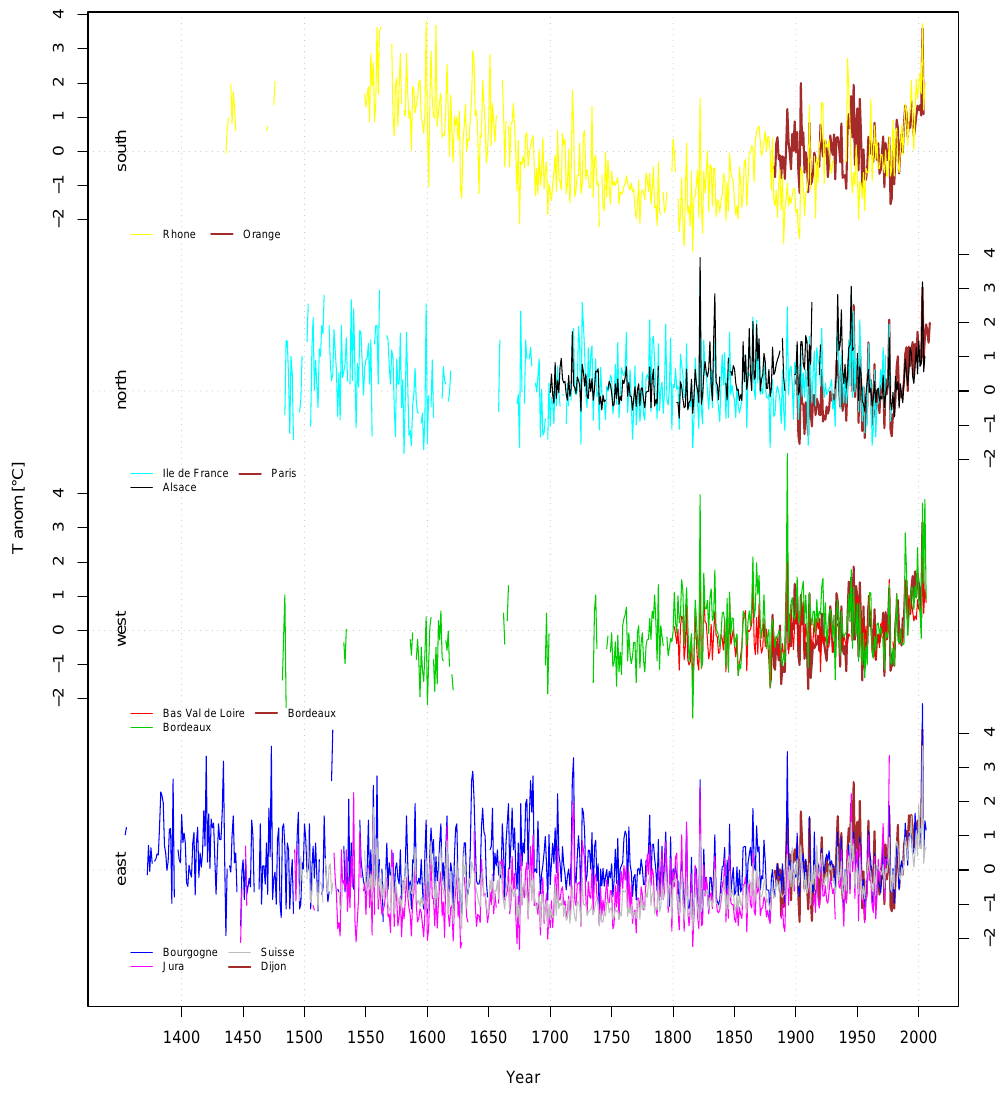
Fig. 2. Reconstructed temperature anomalies of the mid-March to August temperature deduced from GHD in four French regions (South, North, West and East: thin lines). Heavy brown lines indicate observed temperature anomalies from the ECA&D database (Klein-Tank et al., 2002) and homogenized data from M´et´eo-France (O. Mestre, personal communication, 2008) for Orange, Paris, Bordeaux and Dijon cities.